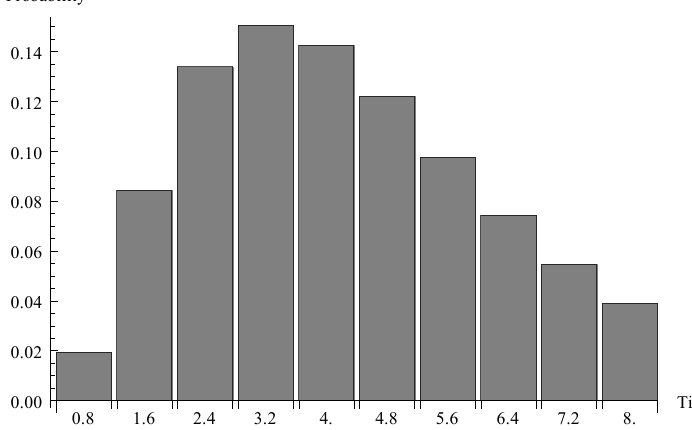
Figure 5. Distribution of idle period duration for λ = 0.7.